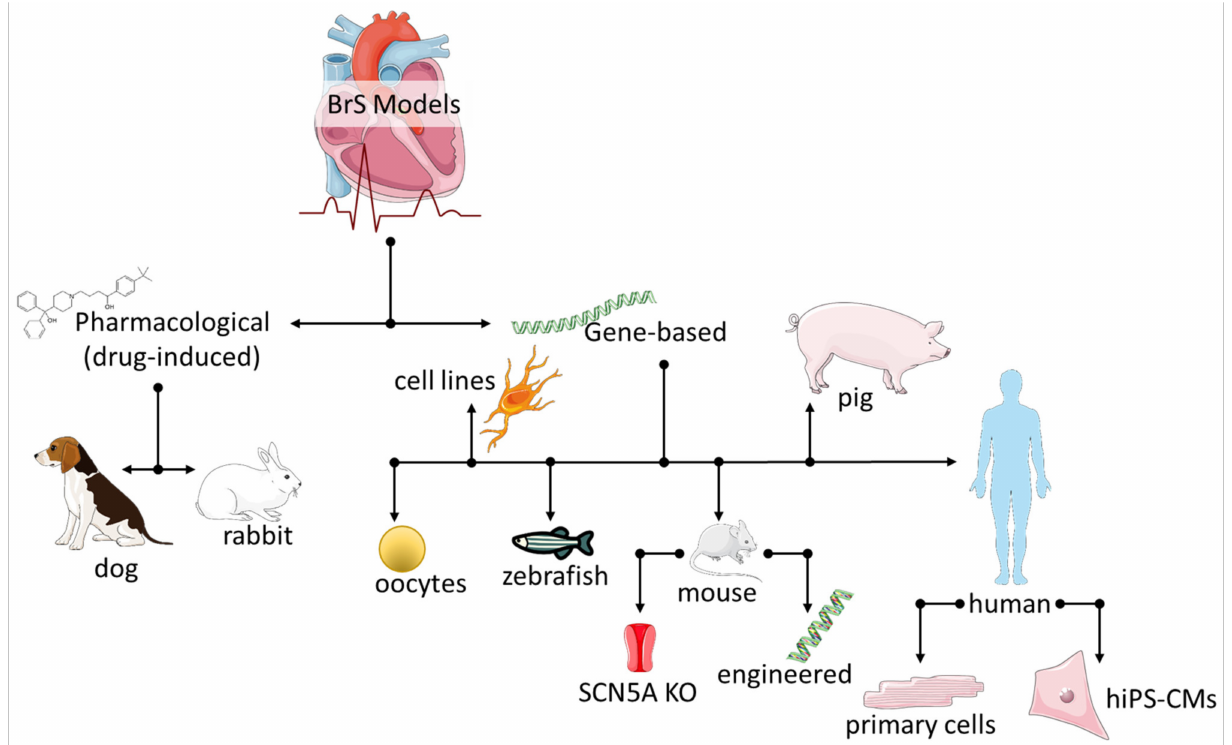
Figure 1. Experimental cellular and animal models developed throughout the years for the study of BrS-related protein variants with a BrS-like symptomology. The figure was partly generated using Servier Medical Art, provided by Servier, licensed under a Creative Commons Attribution 3.0 unported